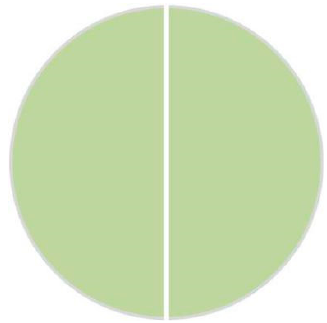
Figure 13. Schematic diagram of the L/D boundary.